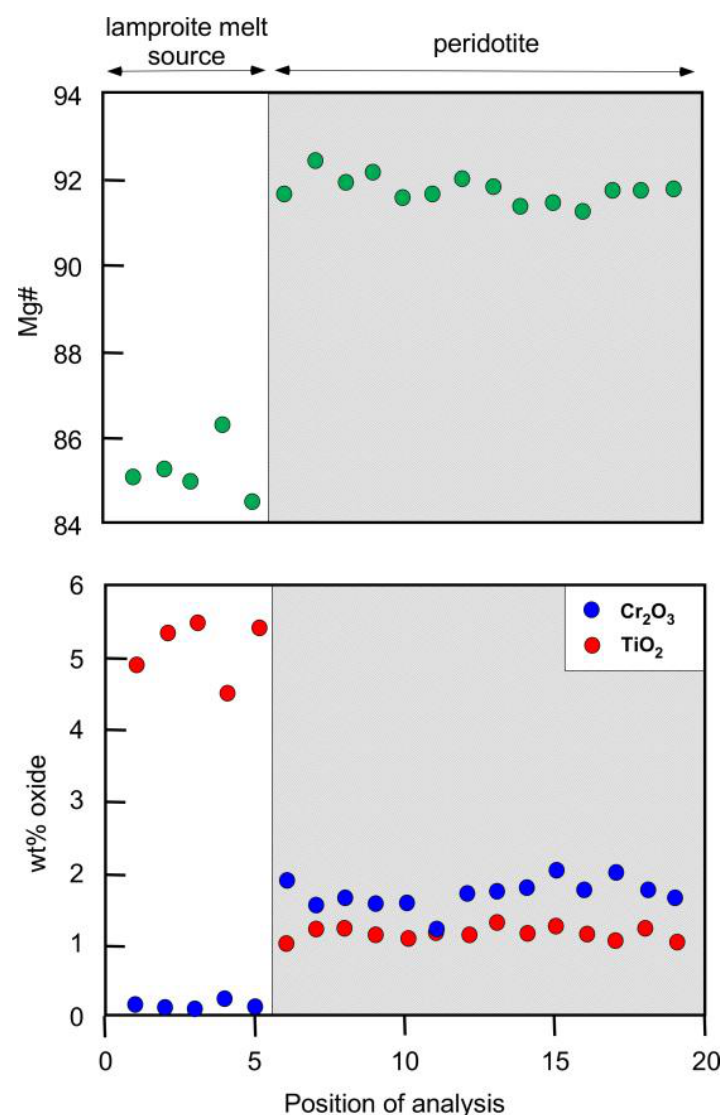
Figure 3. Traverse of phlogopite compositions in lamproite and peridotite sections of Experiment G132 (2 GPa, 1050 °C), plotted at approximately equal intervals from bottom to top of capsule (left to right). Peridotite section indicated by grey background. New phlogopites grown in the peridotite have higher Mg# and Cr 2 O 3 as well as lower TiO 2 than those crystallizing as a liquidus phase in the lamproite and show consistent compositions throughout the peridotite section. Table 3. Phlogopite compositions in dynamic metasomatism experiments.